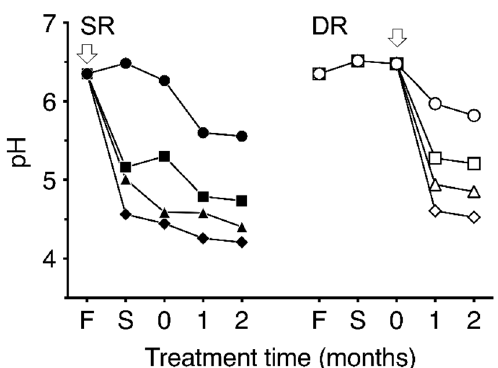
Figure 3. Time-dependent changes in pH during the dehydration and salting process with different concentrations of McIlvaine buffering agent. SR indicates dehydration by salting (shio-oshi takuan-zuke); DR indicates dehydration by sun-drying (hoshi takuan-zuke). The arrows denote the time point of salt addition. F denotes the pH obtained from fresh daikon. S denotes the pH obtained from the dehydrated daikon after one week of salting. “0” denotes the start of salt-aging process. Symbols refer to di ff erent concentrations of McIlvaine bu ff ering agent (mmol/kg): ● , SR0; ■ , SR10; ▲ , SR20; ◆ , SR40; ○ , DR0; □ , DR10; △ , DR20; ◇ , DR40. Values are mean ± standard deviation (SD) ( n = 3). The error bar cannot be displayed because the standard deviation is small.